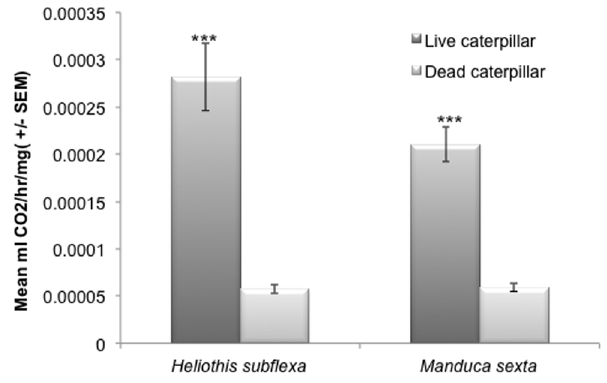
Figure 5. Mean levels of CO 2 production related to Basal Metabolic Rate (BMR) by live vs. dead caterpillars of two moth species. The mean ( 6 S.E.) amount of CO 2 (ml CO 2 /hr/gram of body weight) produced by live and dead fourth instar caterpillars of Heliothis subflexa and Manduca sexta was analyzed using respirometer assays. GLM was used to examine the differences between means for the two treatments (Live vs. Dead, N=7). The amount of CO 2 produced by live M. sexta caterpillars was significantly higher than that of dead caterpillars ( P , 0.0001; F 1, 12 =63.59, N=7). Live caterpillars of Heliothis subflexa also produced significantly higher amounts of CO 2 compared to dead ones ( P , 0.0001; F 1, 12 =39.34, N=7).